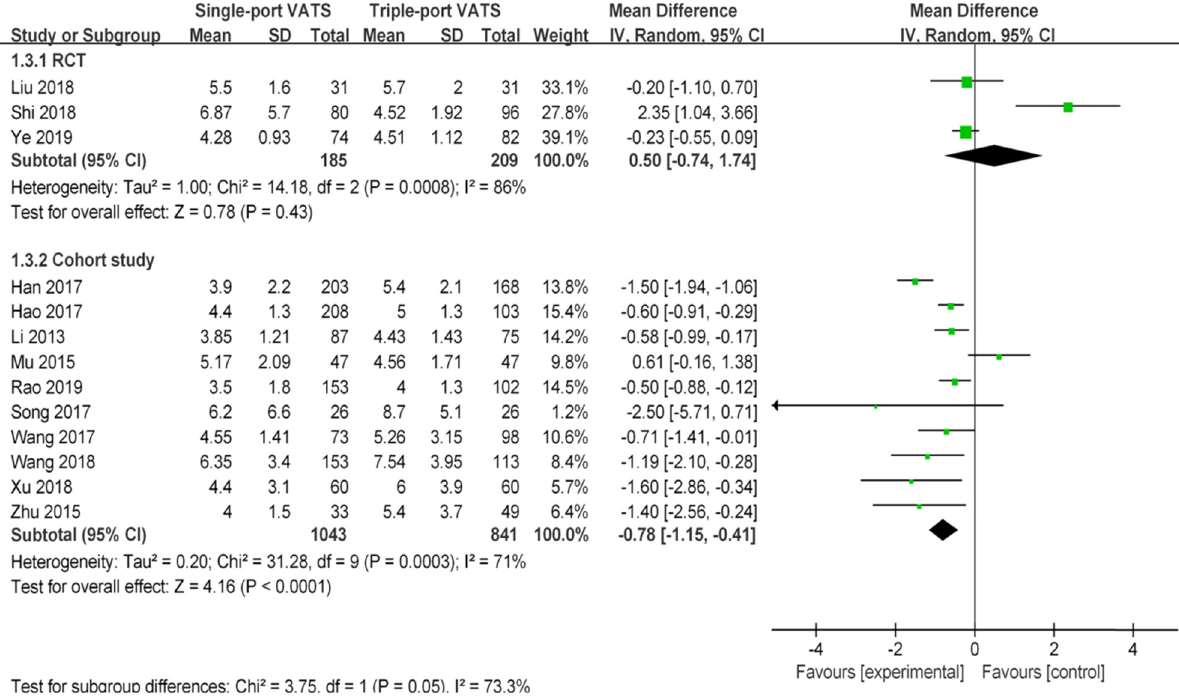
Figure 4: Forest plots of chest tube duration for single - and triple - VATS lobectomy. For each study, the estimated OR ( shown as square ) and its 95% CI ( shown as horizontal line ) were plotted. The pooled OR and 95% CI were plotted as black diamond.